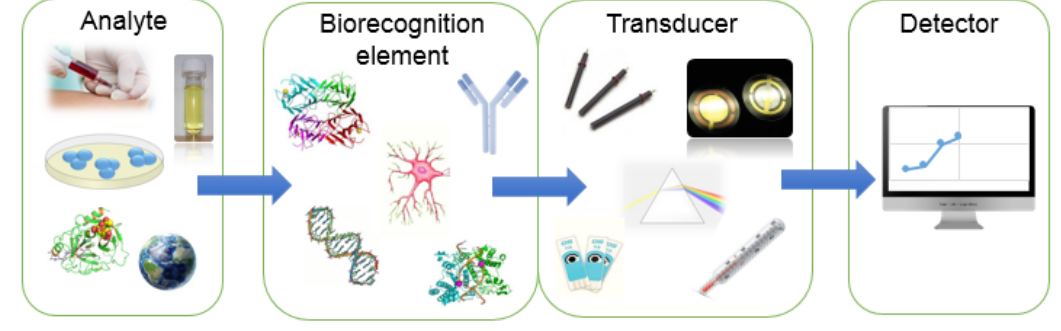
Figure 3: A scheme of the biosensor with an analyte, a biorecognition element, a transducer, and a